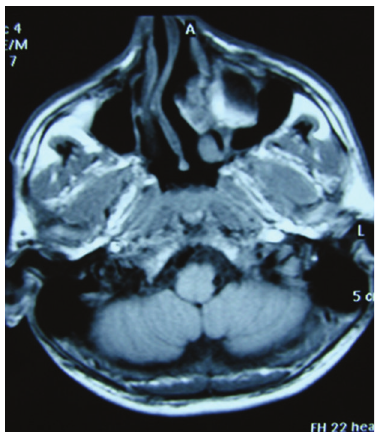
Figure 3: Cranial MR: regression of the Brown tumor which local- ized in the left maxillary